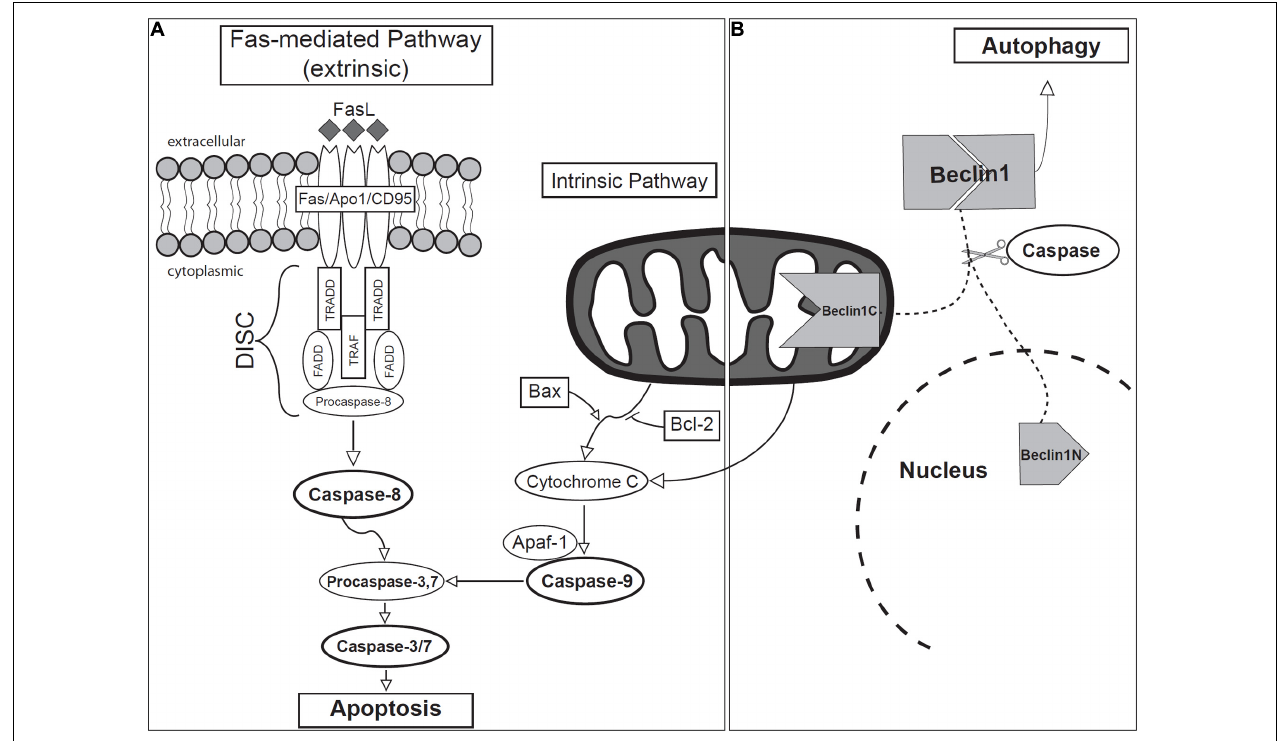
FIGURE 4 | Schematic of (A) apoptotic and (B) autophagic signaling during